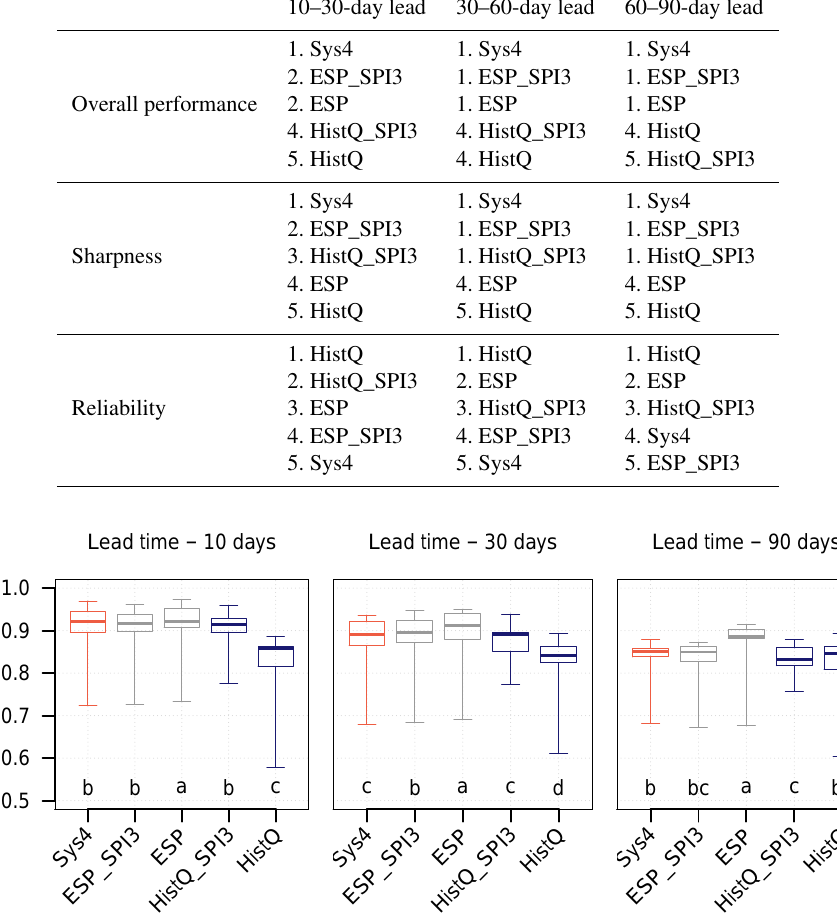
Figure 8. Ranges of the area under the curve (AUC) of the ROC diagram based on the 80th exceedance percentile for each of the five selected ensemble forecasts (Sys4, ESP, HistQ, ESP_SPI3, HistQ_ SPI3). Box plots gather the AUC values for the 16 catchments. The boxes extend to the 25th and 75th percentiles, and the whiskers extend to the data extremes. Graphs are presented for 10-, 30- and 90-day lead times (columns). The letters below the box plots result from the Friedman test. For a given lead time, two box plots sharing a letter are not significantly